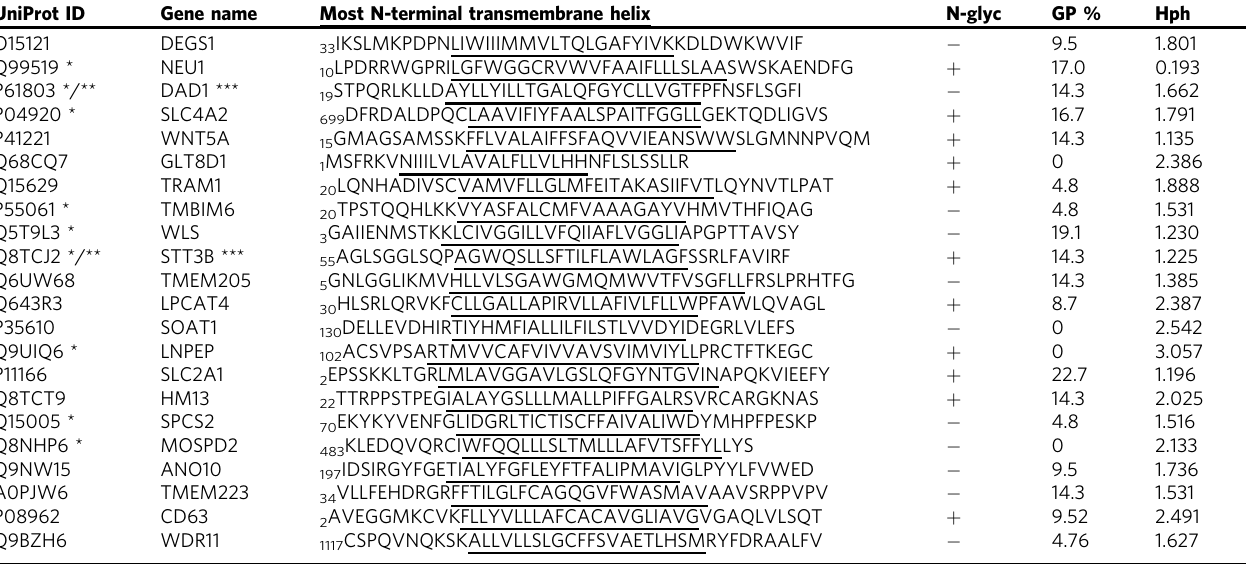
Table 2 Primary structures of transmembrane helices of putative TRAP clients without cleavable signal sequences UniProt ID